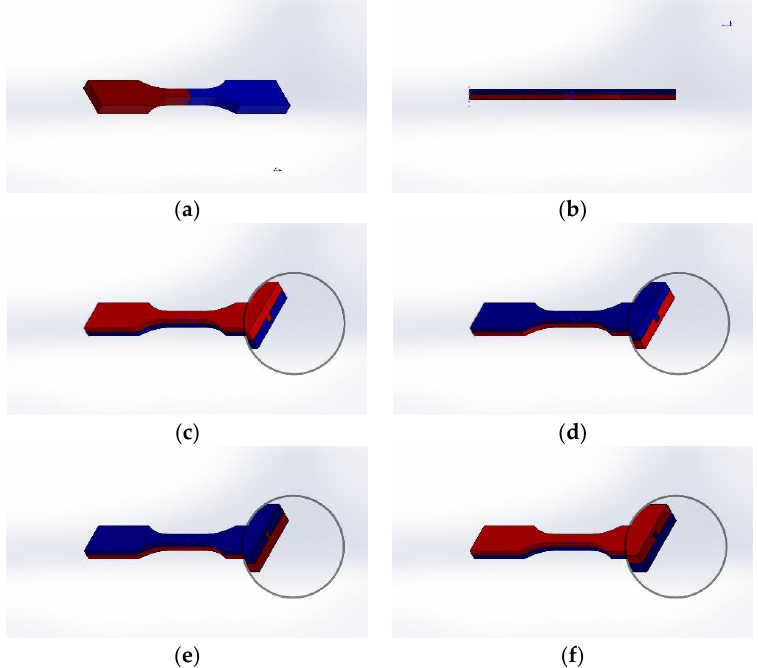
Figure 2. CAD design for fabricated HM samples: ( a ) half-length; ( b ) half-thickness; ( c ) half-thickness male cube; ( d ) half-thickness female cube; ( e ) half-thickness male T; ( f ) half-thickness female T. Red color represents the FDM preform and blue the IM substrate. Table 1. The range of fabricated specimens.